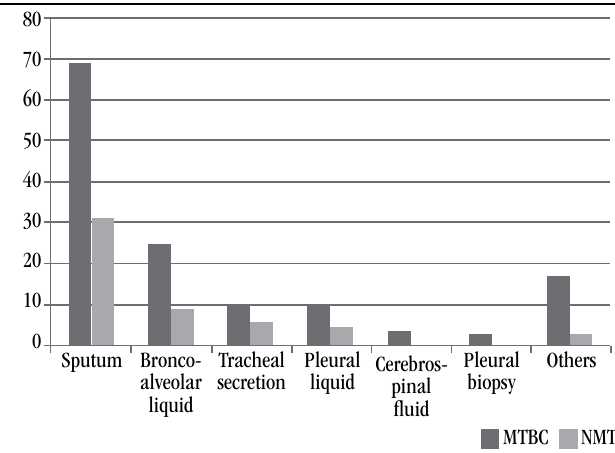
figurE 1 – Percentages of mycobacterium classification isolated from 2008 to 2010 Group I: photochromogenic; group II: scotochromogenic; group III: non- chromogenic; group IV: rapid growth.